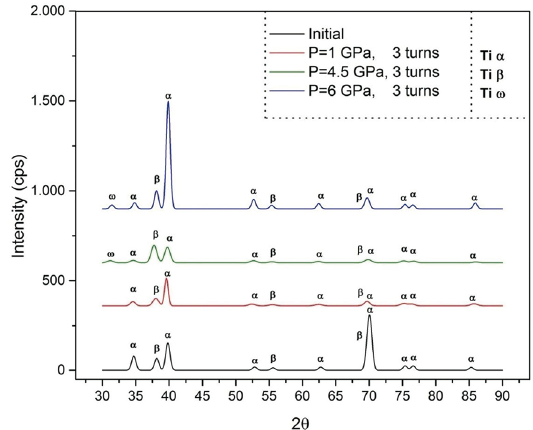
Figure 6. XRD patterns corresponding to samples processed by